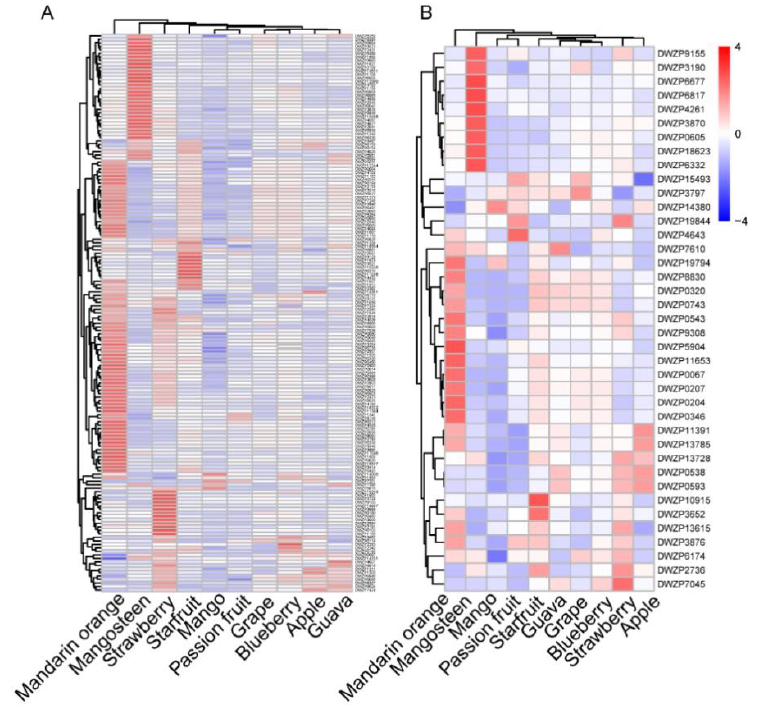
Figure 5. The accumulation pattern of different flavonoids and chalcones in different kinds